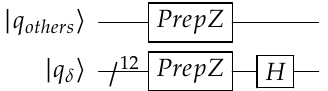
Figure A1. Initialization quantum circuit for QPULBA 2-2-1. Read tape : The quantum circuit for read implements a multiplexer with the tape as the input signals and the binary coded head position as the selector lines, as shown in Figure A2. The read head is the